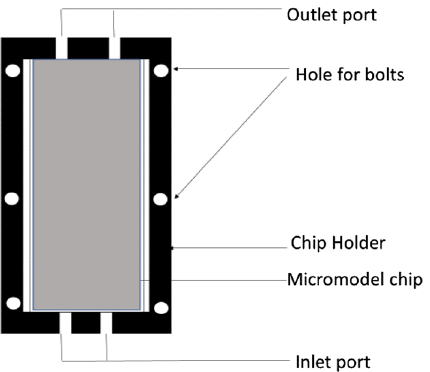
Fig. 4 Oil and water phase in a triangular pore (Courtesy: Martin